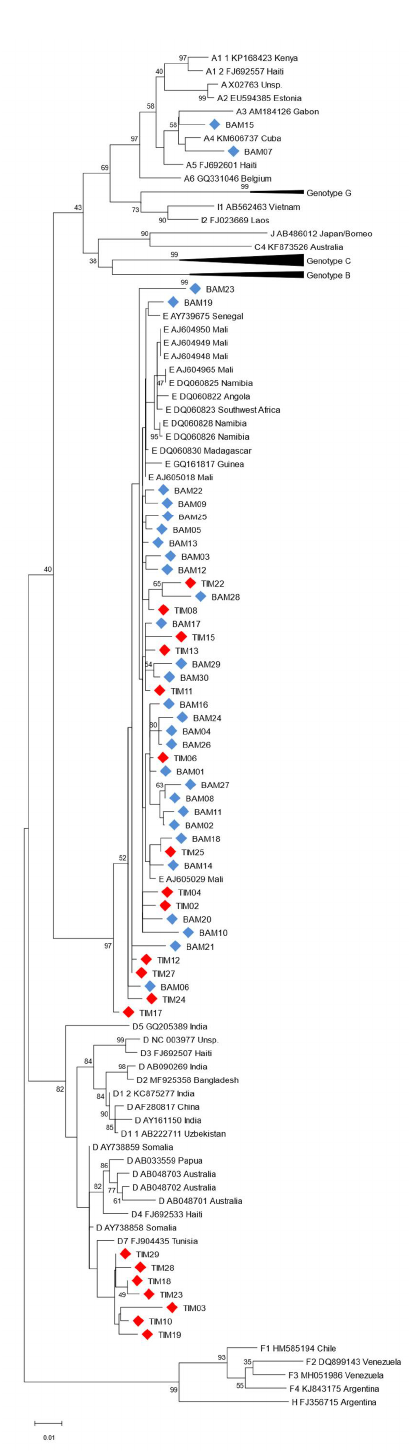
Figure 2. Phylogenetic analysis of HBV sequences based on 964 nt of the viral HBS gene compared to HBV reference sequences. The phylogenetic tree was constructed using the maximum likelihood method and the Tamura–Nei model [37]. The tree with the highest log likelihood ( − 9422.64) is shown. The percentage of trees in which the associated taxa clustered together is shown next to the branches. This analysis involved 118 nucleotide sequences with a total of 964 positions in the final dataset. Reference sequences are shown as Genotype, GenBank accession number and country of origin (where specified). The points shown with blue diamonds and labeled BAM represent samples collected in Bamako (Mali) and the points shown with red diamonds and labeled TIM represent samples collected in Timbuktu